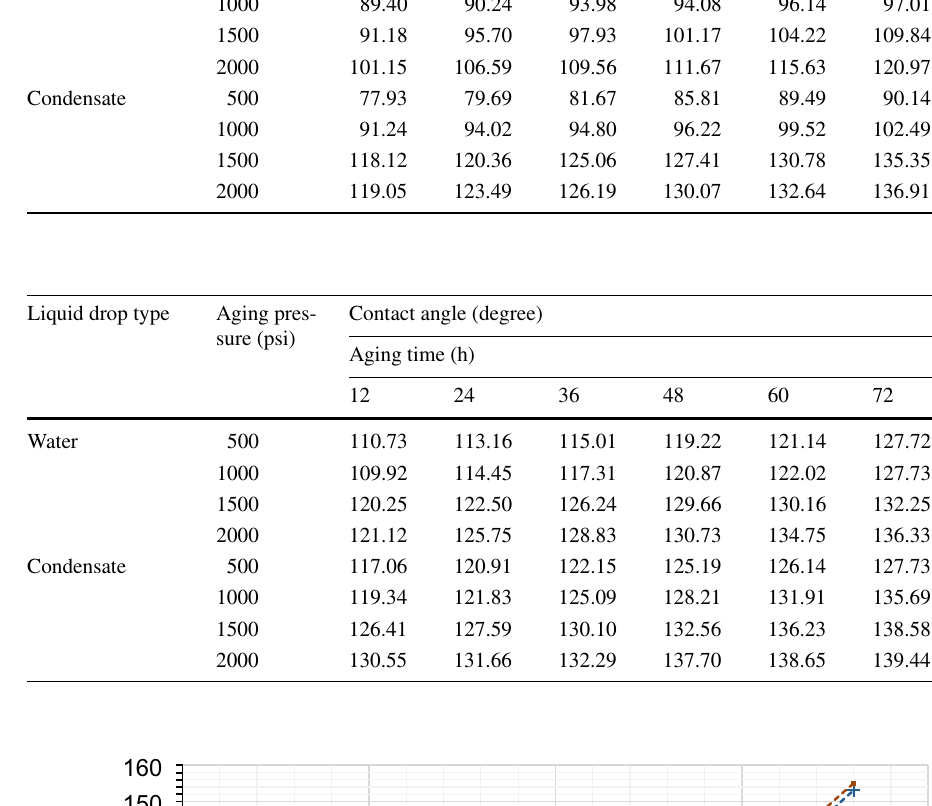
Fig. 6 The obtained curves from the contact angle experi- ments due to the droplet of water and condensate in the presence of the air on the